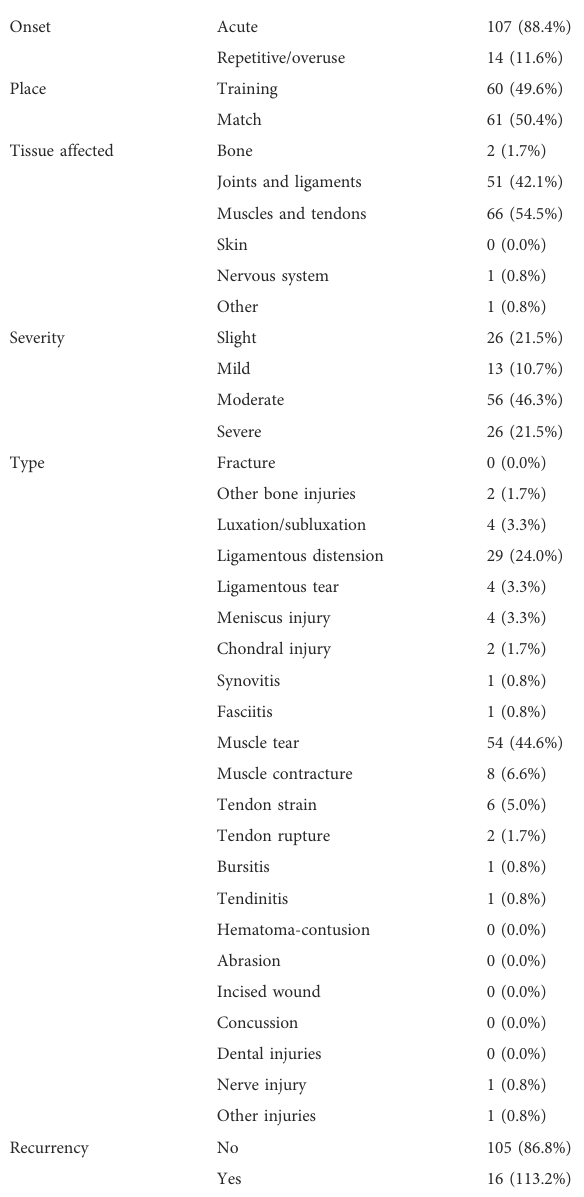
TABLE 4 Injury characteristics in professional soccer players during the 2021/2022 season.